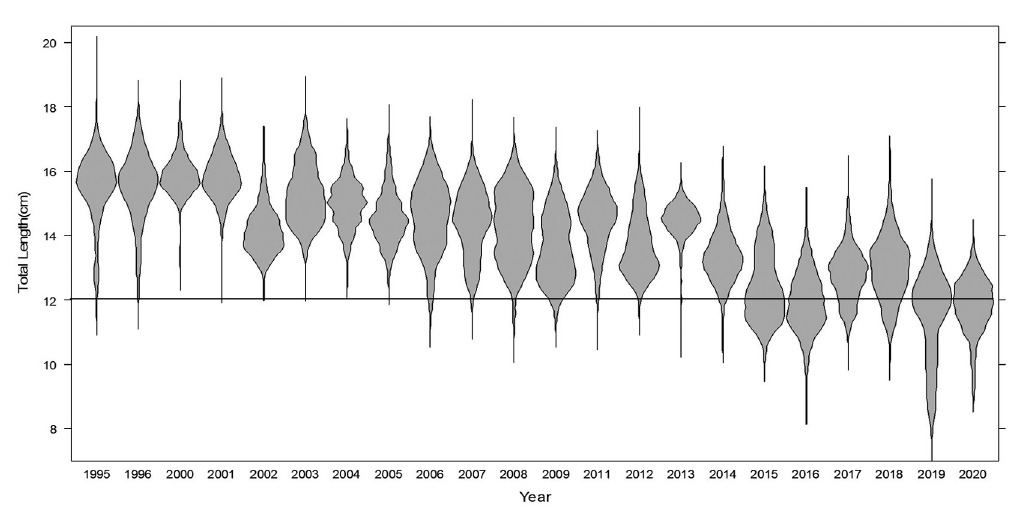
Fig. 2. – Distribution of female total length (cm). Horizontal line indicates 12 cm total length